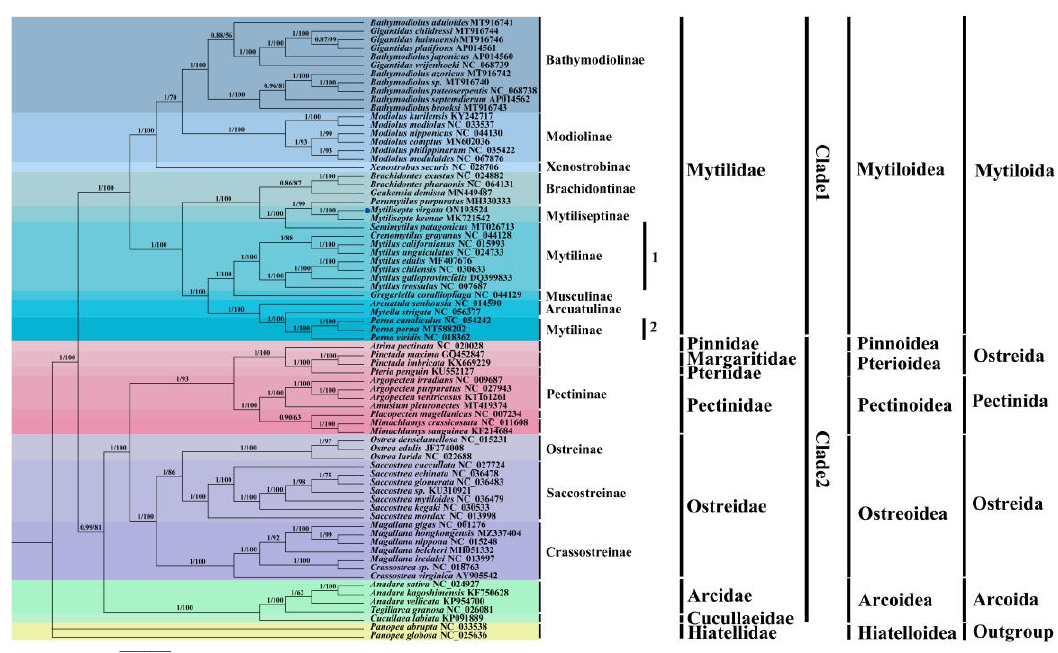
Figure 7. The phylogenetic tree for M. virgata and other bivalvia species based on 12 PCGs. Phylogenetic tree inferred using Bayesian inference (BI) and maximum likelihood (ML) methods. The value on the left side of the slash is the posterior probabilities estimated by the Bayesian tree, and the value on the right side is the maximum likelihood tree. The blue dot indicates M. virgata in this study.